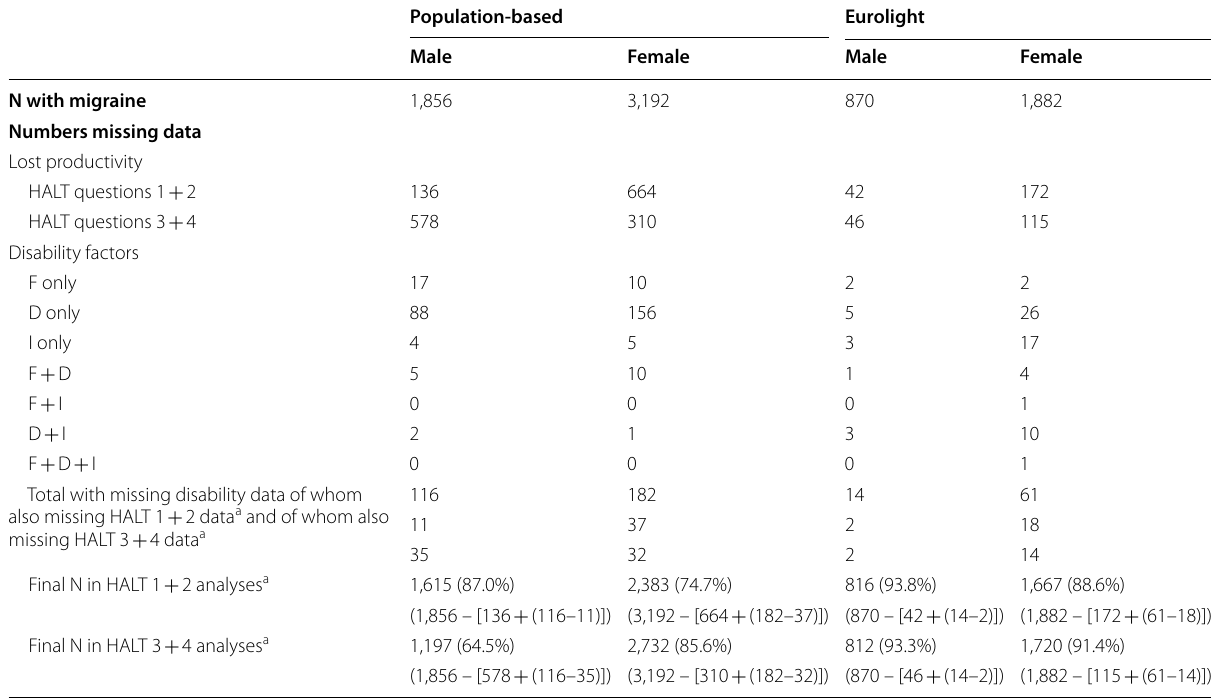
2] and household days +